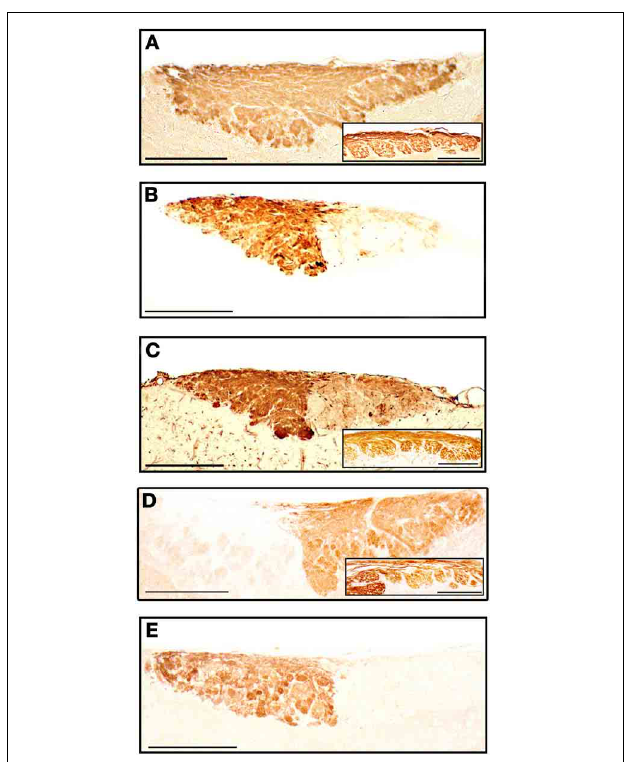
FIGURE 11 | Parasagittal sections of the olfactory bulb through the AOB (left anterior, right posterior) stained with anti-OMP (A), UEA-I (B), LEA (C), anti-G α 0 (D) and anti-G α i 2 (E). Insets show the nervous and glomerular layers of the MOB. Scale bars: (A) 250 μ m; (B–E) and insets, 200 μ